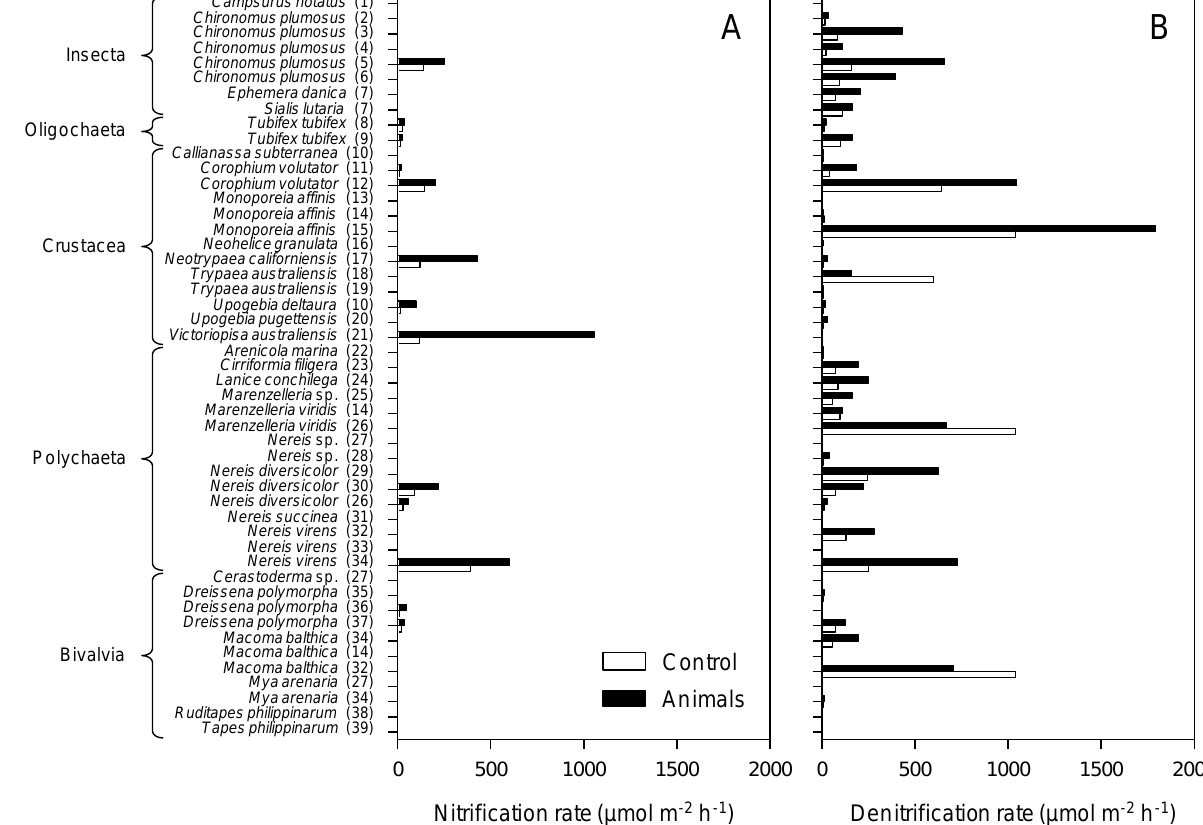
Fig. 3. Data from 39 published studies in which (A) nitrification rates, (B) denitrification rates, (C) ammonium fluxes, and (D) nitrate fluxes were compared between sediment with and without single macrofauna species. Data were extracted from tables, figures, and text of studies that are indexed together with environmental and experimental settings in Table 2. Average rates and fluxes are given for sediment without macrofauna (control) and sediment with the highest density of macrofauna (animals) and were re-calculated to µmol Nm − 2 h − 1 . Positive fluxes are directed from sediment to water, negative fluxes from water to sediment. No bar is displayed when information was not available. Variation of data is found in the original references (numbers in